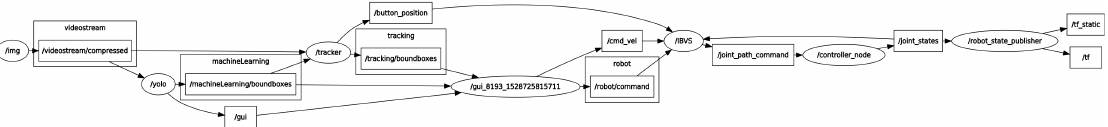
Figure 4. The topics (rectangles) and the nodes (ellipses) of the Robotic Operating System